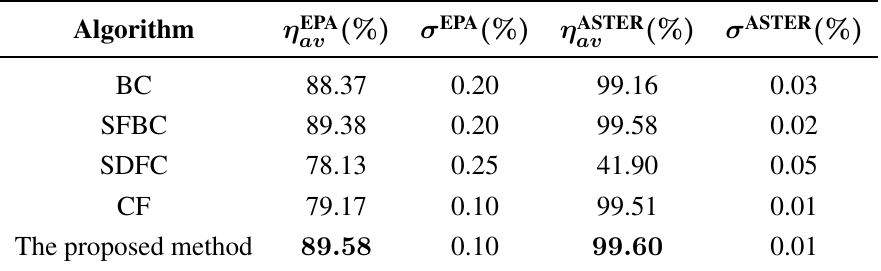
Table 3. Accuracy comparisons of different algorithms with the 2 datasets and SNR = 45 dB.